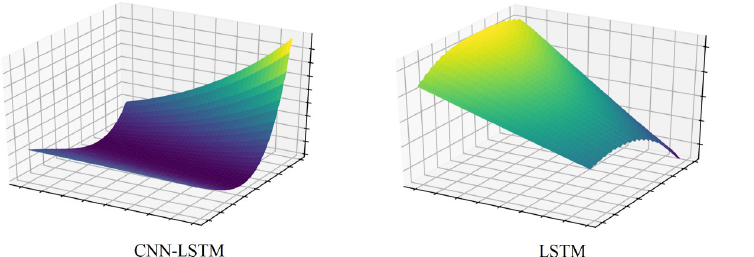
Fig 7. Comparison of loss landscapes of LSTM and